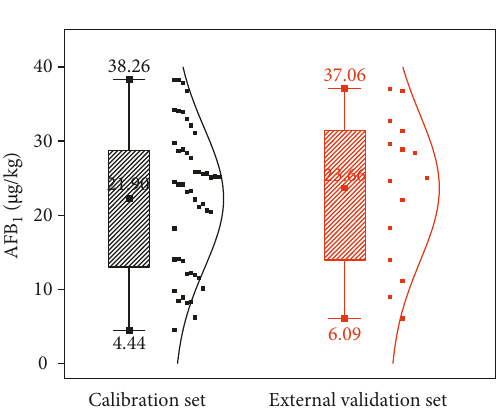
1 concentrations for both